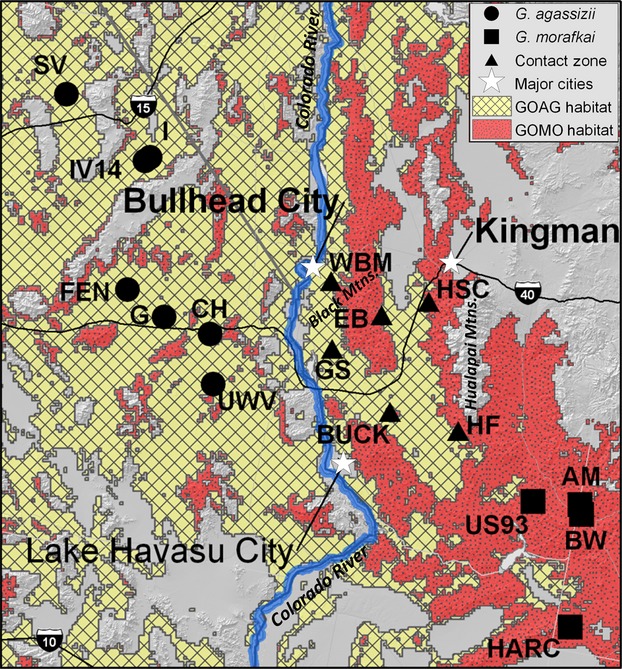
Probability distribution map of the potential range of G. agassizii and G. morafkai where “stippled pattern” represents predicted G. morafkai (Gomo) habitat and “boxed pattern” represents predicted G. agassizii (Goag) habitat. Gray background is not predicted to be habitat for desert tortoises. Habitat suitability modeling of habitat use and niche separation of species based on the genotype of sampled individuals (G. agassizii; G. morafkai, or admixed) determined from the STRUCTURE analysis Q-values. Sampling sites include G. agassizii (circles) in California, G. morafkai (squares) in Arizona, and individuals from the secondary contact zone in Arizona (triangles). Location is an inset map of Fig.1 and is bisected east/west by the Colorado River.